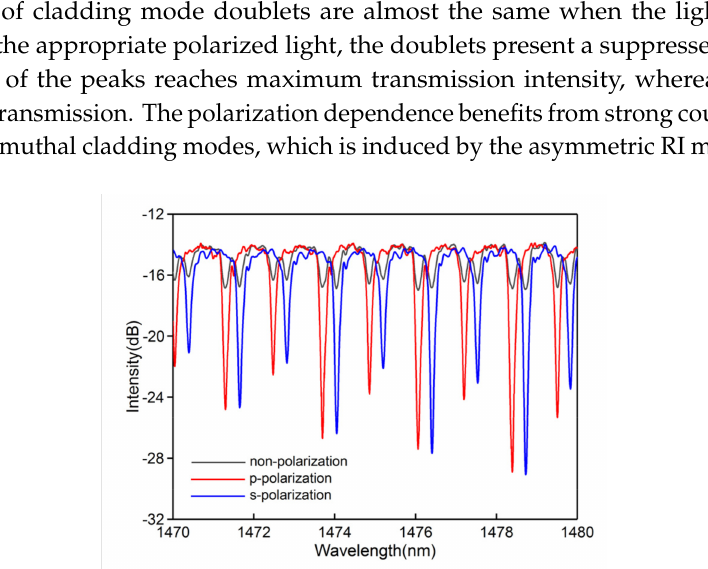
Figure 4. Transmission of cladding mode resonances at three di ff erent polarization states.